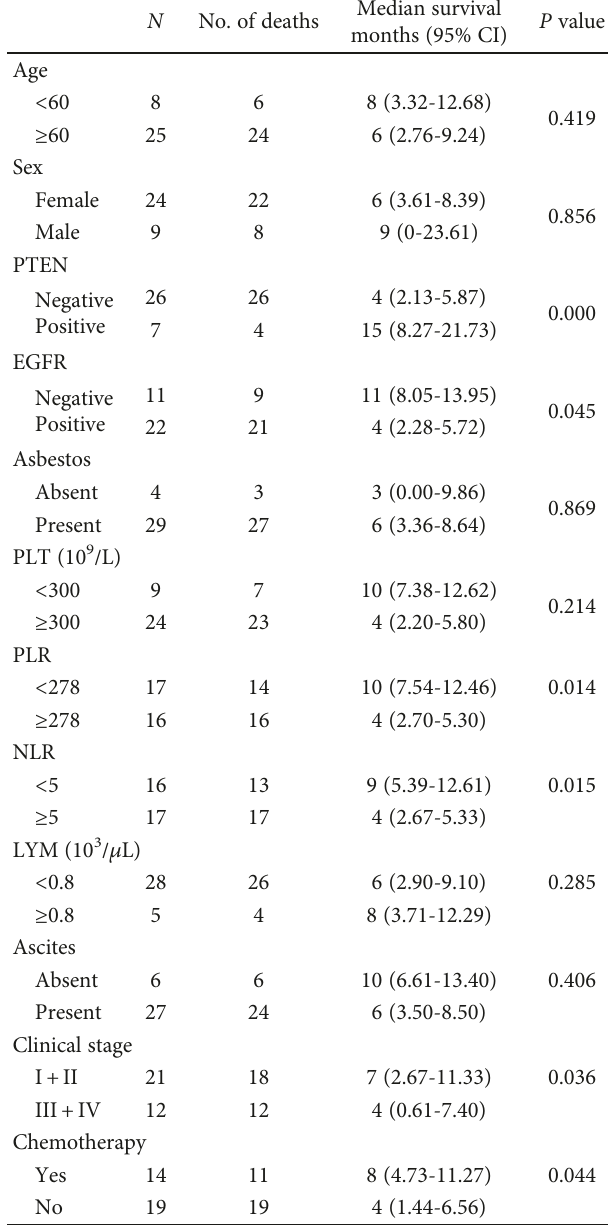
Table 4: Univariate analyses of association of prognostic factors with overall survival of MPeM.